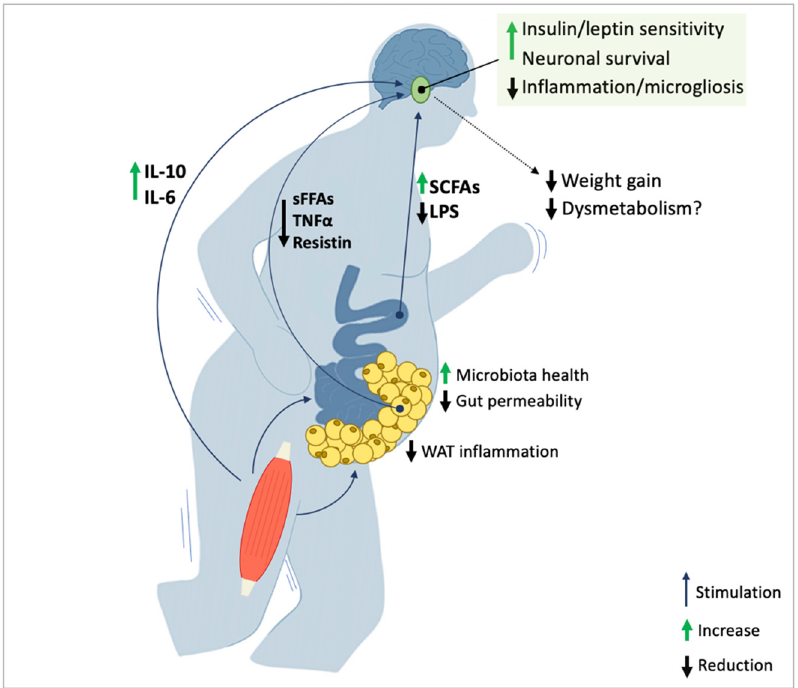
Figure 3. Exercise can modulate mediators involved in the regulation of hypothalamic health. Reg- ular training suppresses microglial response and downregulates the main markers and pathways of inflammation (e.g., TNF α , NF-k β and IKK β ) in the ARC and other energy-regulatory nuclei in the MBH. Exercise-induced anti-inflammatory response in the hypothalamus pairs with increased leptin and insulin sensitivity, improved neuronal survival in the ARC, and associates with lowered food intake and body weight control, which remarks the central role of remodulating inflammation to restore a proper hypothalamic functionality. The anti-inflammatory/regulatory effect of exercise on the hypothalamus is partly achieved through the increase in myokines such as IL-6 and IL-10. These cytokines mediate the inhibitory effect on hypothalamic inflammation enhancing leptin sen- sitivity and adjusting energy expenditure rates during/following exercise. The positive activity of regular exercise on WAT dysfunction along with the immunomodulatory effect of training are critical for the suppression of key mediators (e.g., FFAs, Resistin, AGEs) that produce inflammation and insulin/leptin resistance in the ARC. The exercise-induced switch in microbiota is responsible for augmented production of SCFAs, with potential neuroprotective and anti-inflammatory effects on the hypothalamus; the improvement of the gut barrier following regular exercise lowers the translocation of LPS, preserving the hypothalamus and other brain areas from the development of inflammation. CCL-2 chemokine (C-C motif) ligand 2; IL, interleukin; LPS, lipopolysaccharide; SFCAs, short chain fatty acids; TNF α , tumor necrosis factor- α ; WAT, white adipose